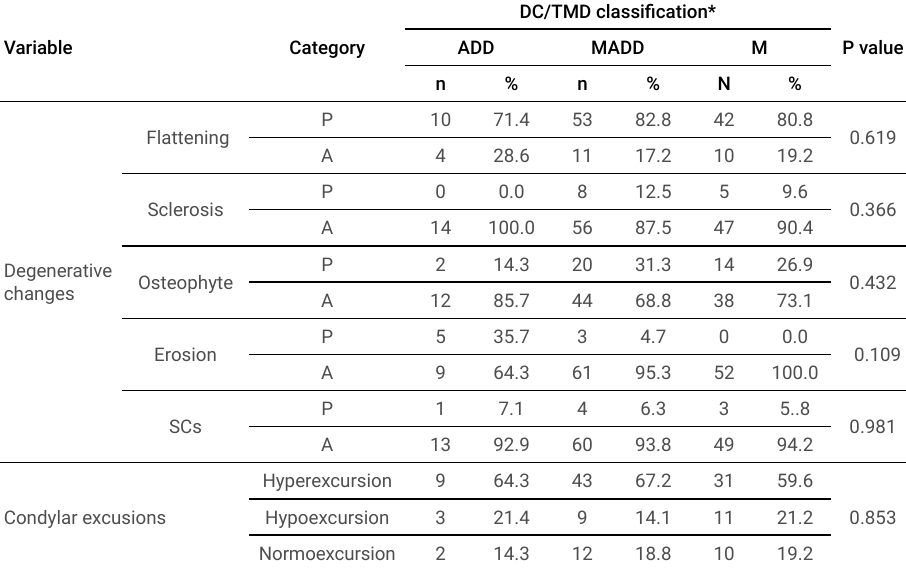
Table 1. Cross tabulation of the occurrence of degenerative changes, estimates of condylar excursion and positions, the DC/TMD and the significance of the likelihood ratio test.